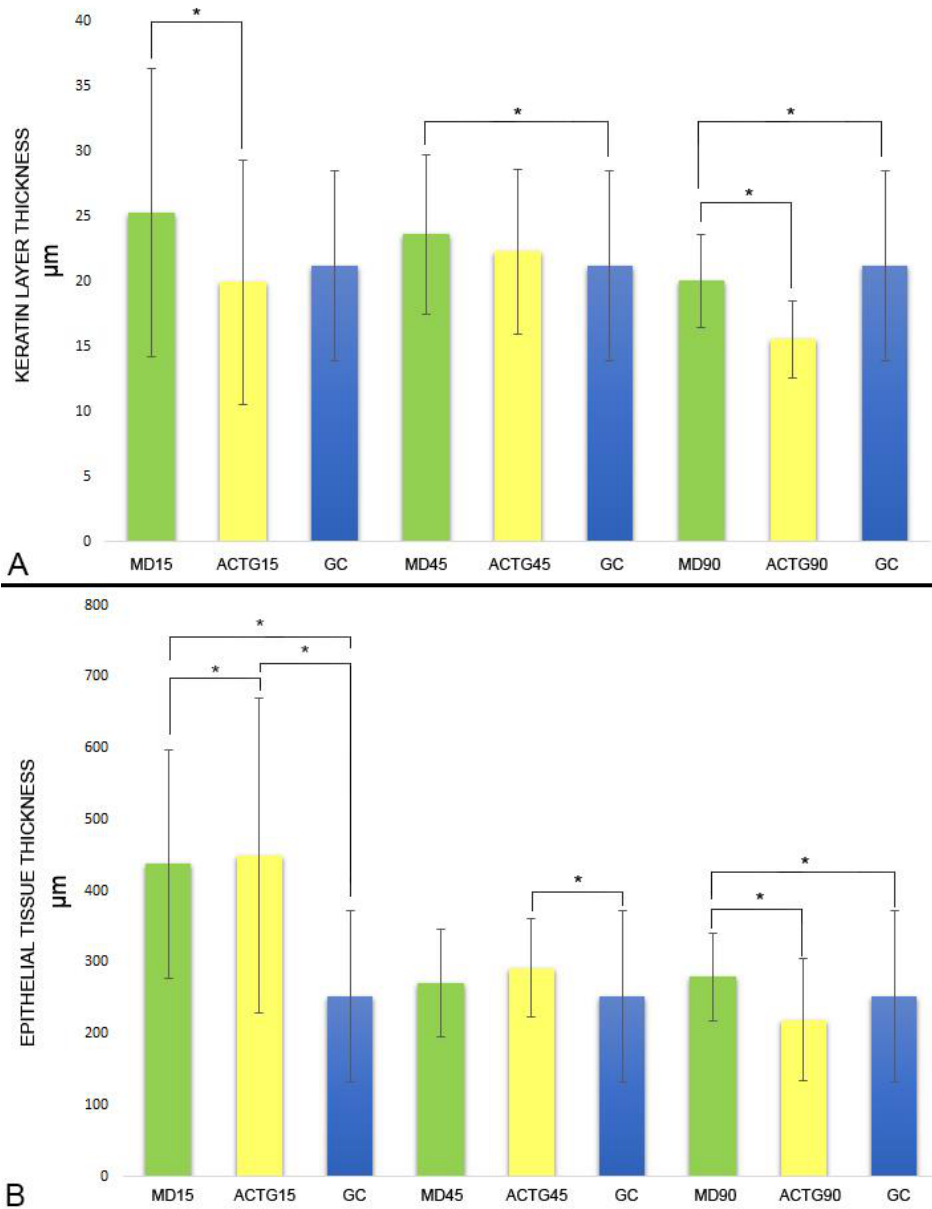
Figure 9. ( A ) Changes in the values of keratin layer thickness from 15 to 90 days. ( B ) Changes in the values of epithelial thickness from 15 to 90 days. * Significant differences were found when performing the Mann–Whitney U test ( p < 0.001) (α = 0.05). MD15: MD values after 15 days; ACTG15: ACTG values after 15 days; MD45: MD values after 45 days; ACTG45: ACTG values after 45 days; MD90: MD values after 90 days; ACTG90: ACTG values after 90